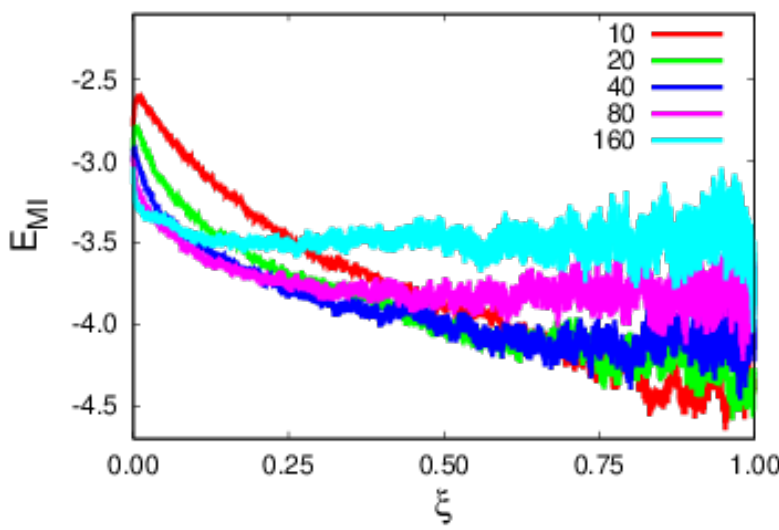
Figure 7. Plots of the monomer–impurity energy contributions in terms of the rescaled time, ξ , for polymers of various sizes.